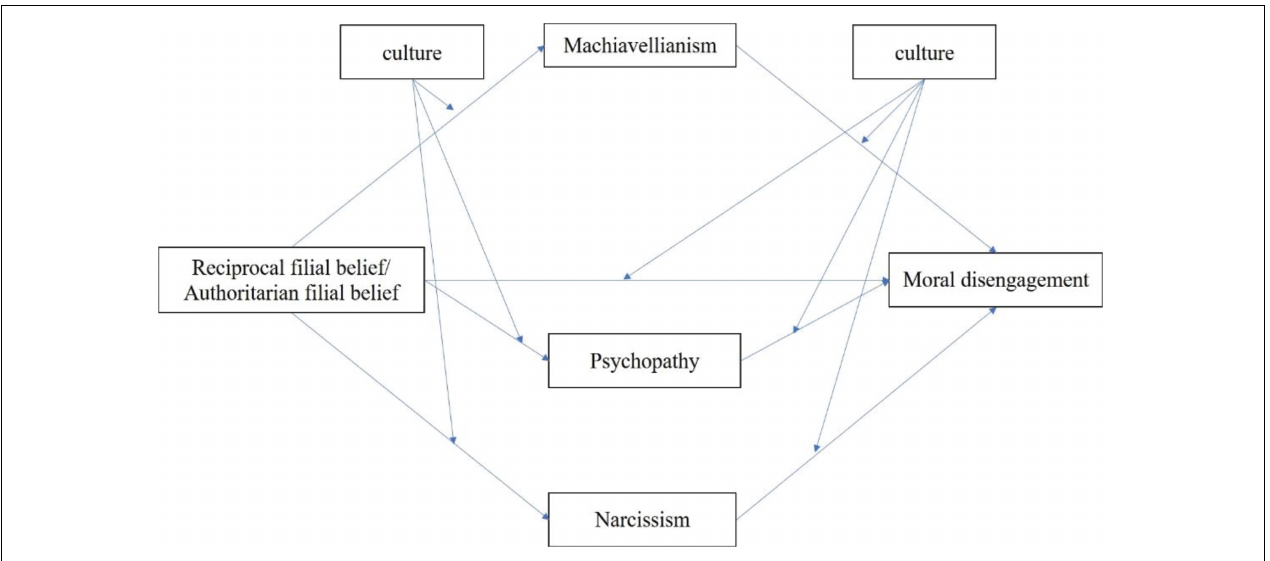
FIGURE 1 | The proposed moderation effects of culture in the mediation